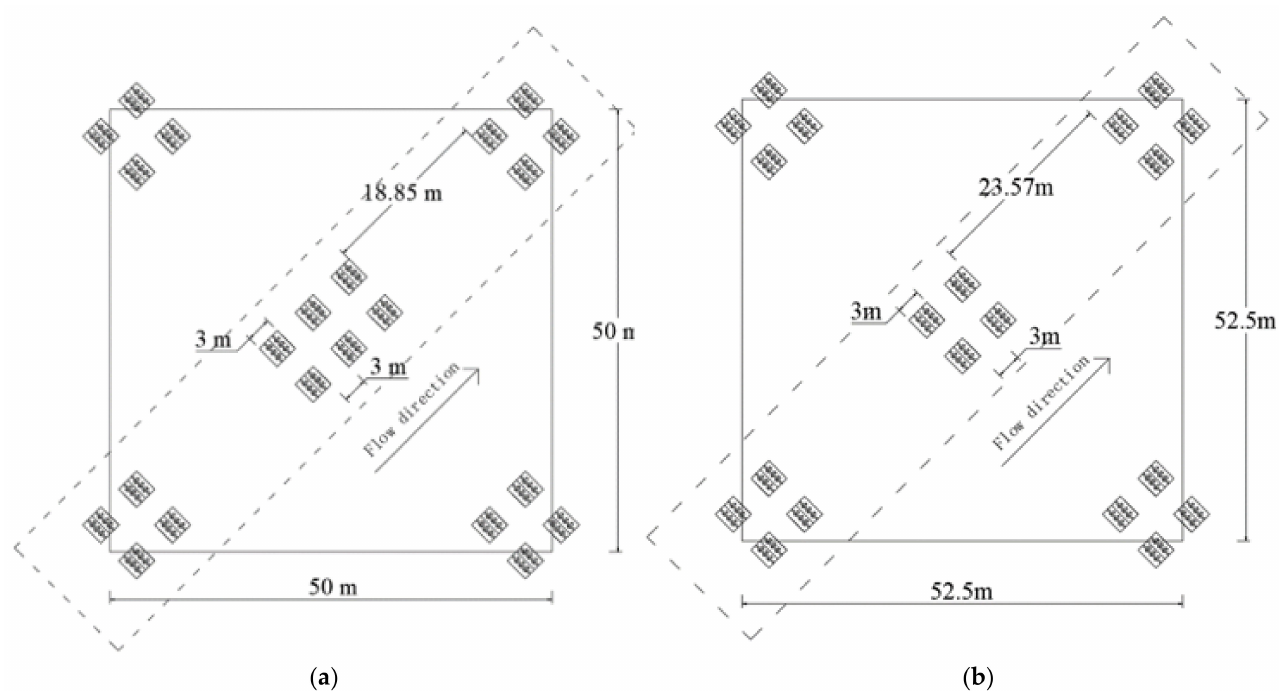
Figure 12. Comparison of M-shaped unit reef before and after the adjustment. ( a ) Original design spacing; ( b ) adjusted spacing.